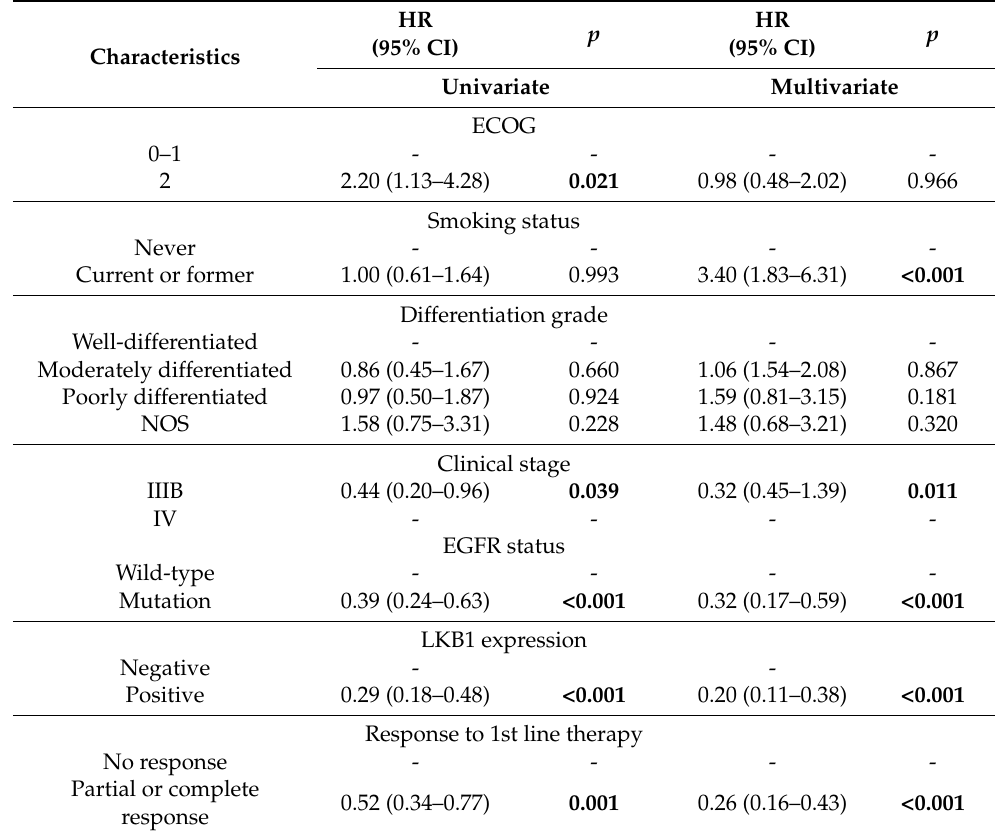
Table 2. Univariate and multivariate analysis evaluating main clinical factors for progression-free survival.